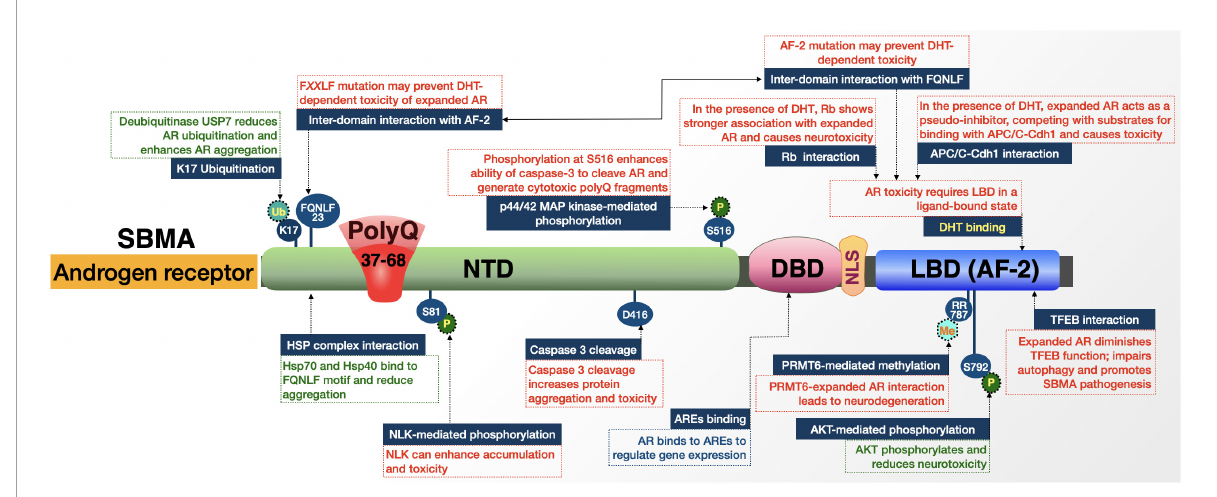
FIGURE4 Graphic representation of the SBMA protein, its domains, interactions, and modifications. Details are in the main text.